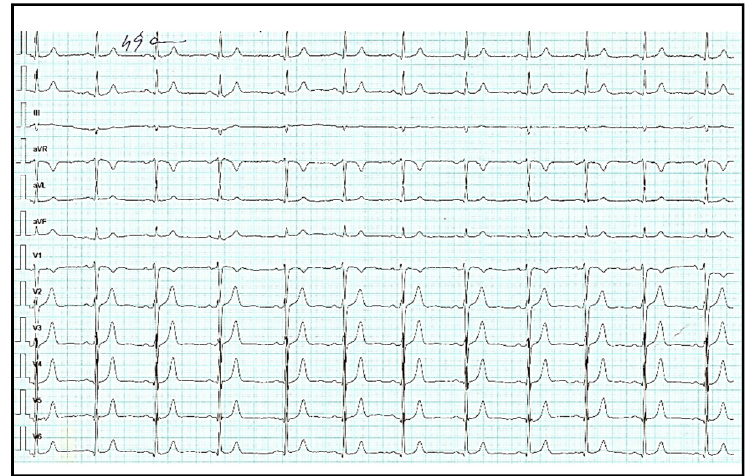
Figure 1. Electrocardiogram revealed sinus rhythm, heart rate 75 beats per minute, intermediate QRS axis, normal morphology.